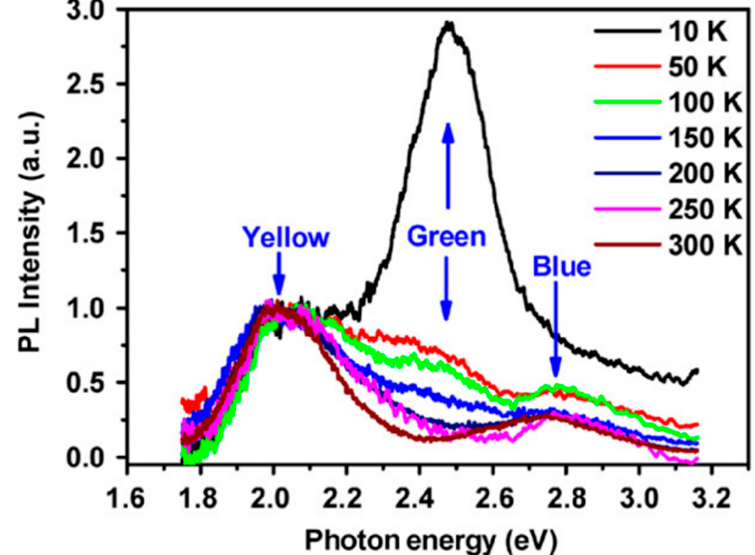
Figure 7. Visible PL spectra of a single ZnO nanowire measured at different temperatures. Three characteristic emission bands (yellow, green, and blue) were observed [113]. Copyright 2008 Elsevier.